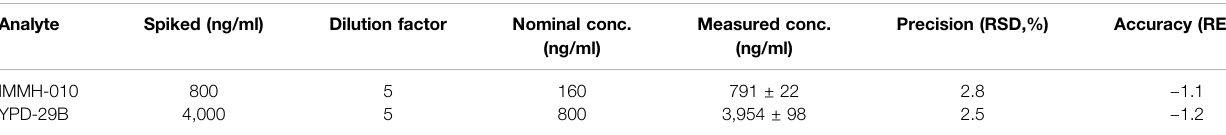
TABLE 6 | Dilution effect of IMMH-010 and YPD-29B in rat plasma ( n (cid:1) 5).